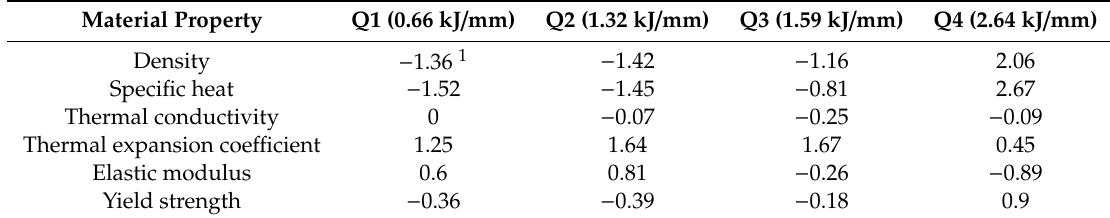
Table 8. Property angular distortion ratios obtained under various heat input conditions.